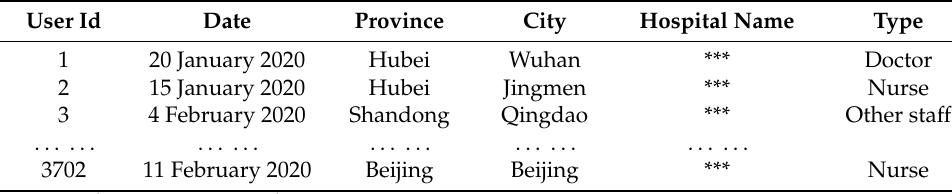
Table 2. Dataset about confirmed healthcare